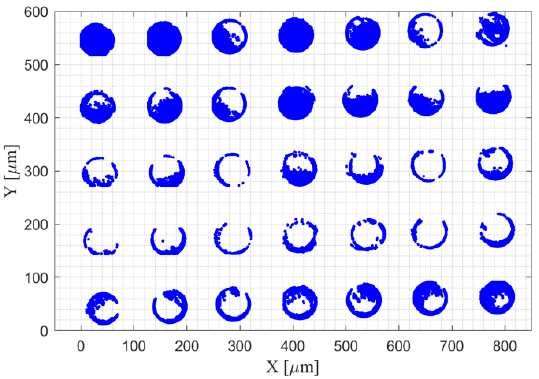
Figure 8. Surface reconstruction of the data of cylinders with outliers removed.